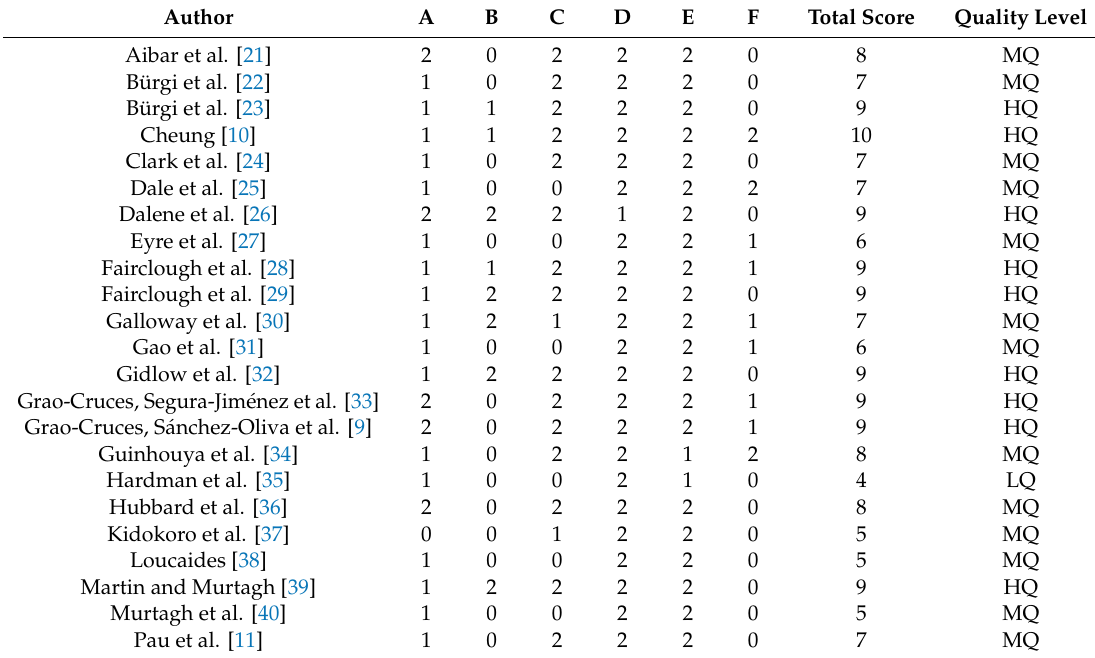
Table 2. List of included studies with quality